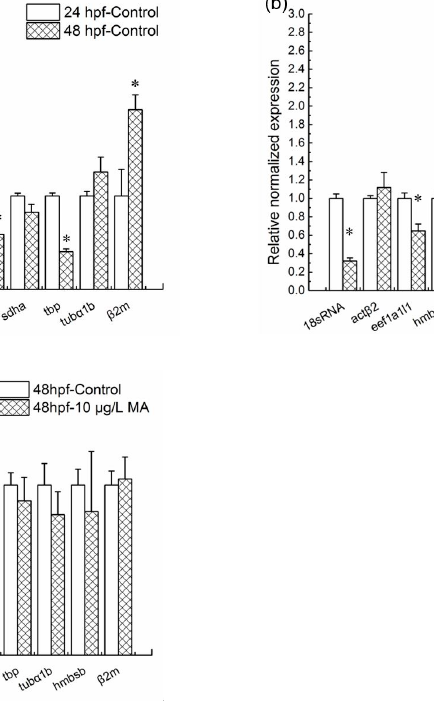
Figure 2. Normalization expression analysis of a set of target genes with gapdh as a reference gene. ( a ) The relative normalized expression levels of target genes at 48 hpf unexposed embryos comparing to 24 hpf unexposed embryos; ( b ) the relative normalized expression levels of target genes at 24 hpf embryos with 10 µ g/L mitoxantrone treatment comparing to 24 hpf unexposed embryos; ( c ) the relative normalized expression levels of target genes at 48 hpf embryos with 10 µ g/L mitoxantrone treatment comparing to 48 hpf unexposed embryos. Each group was conducted in triplicate ( n = 3). All values are expressed as means ± standard error of the mean (SEM). * represents significant difference compared to control, p < 0.05.